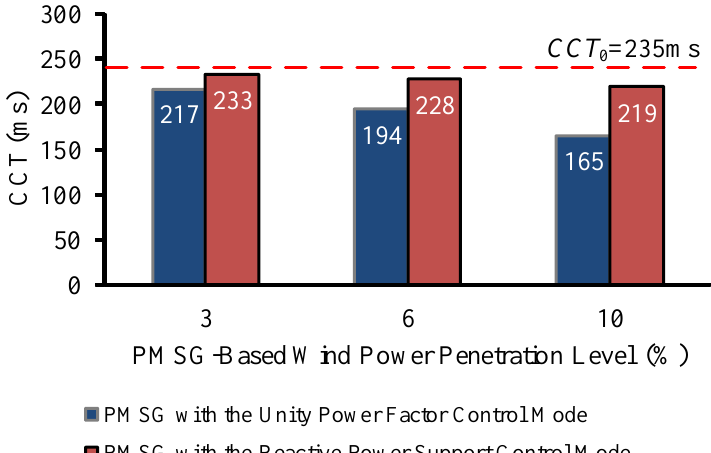
Figure 16. CCTs of the fault on line 10–13 in the scenarios of PMSG-based wind power balanced by G1.